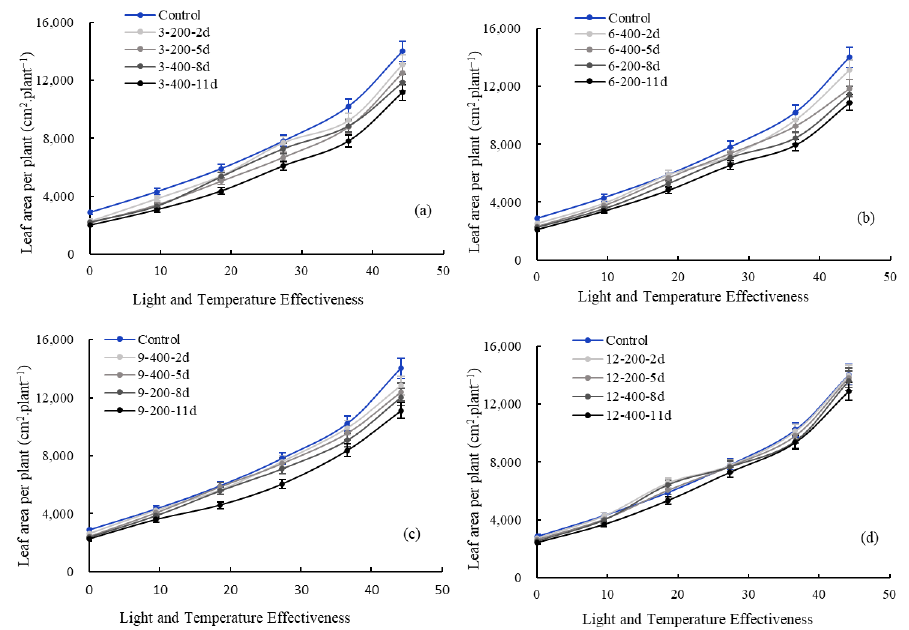
Figure 13. Variation trend of leaf area per plant of cucumber under LT and PL stresses. ( a ) Changes in leaf area of a single cucumber with LTE under 3 °C treatments. ( b ) Changes in leaf area of a single cucumber with LTE under 6 °C treatments. ( c ) Changes in leaf area of a single cucumber with LTE under 9 °C treatments. ( d ) Changes in leaf area of a single cucumber with LTE under 12 °C treatments. Note: Control represents the variation in leaf area per cucumber plant with the increase in LTE under normal growth conditions.